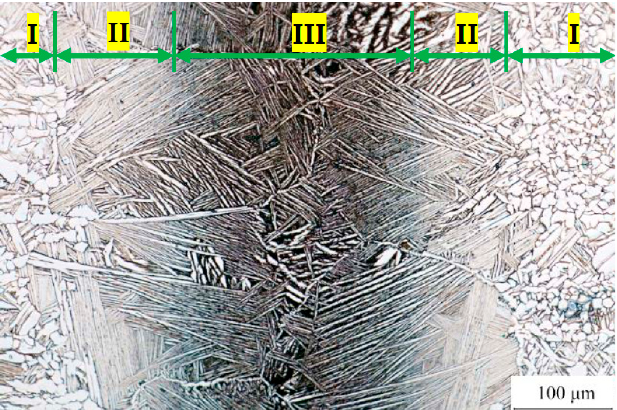
Figure 8. Microstructures around the weld bead of Ti-6Al-4V vacuum brazing. (I—base metal; II— diffusion layer; III—weld